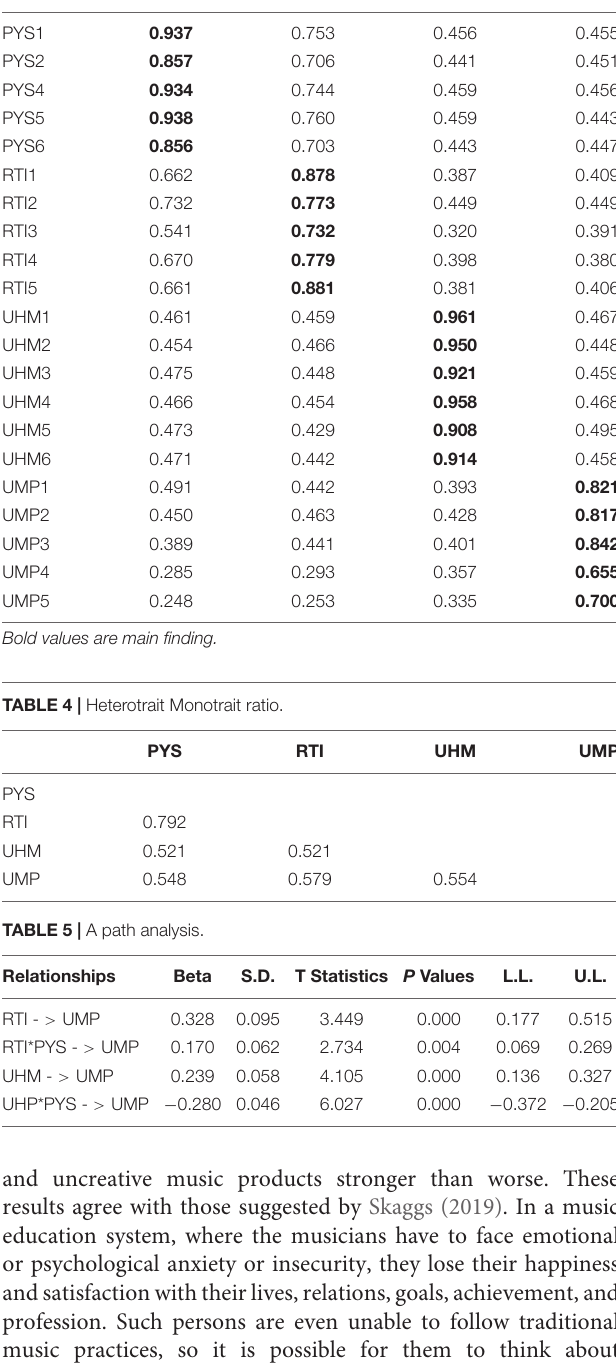
TABLE 3 | Cross-loadings criterion.